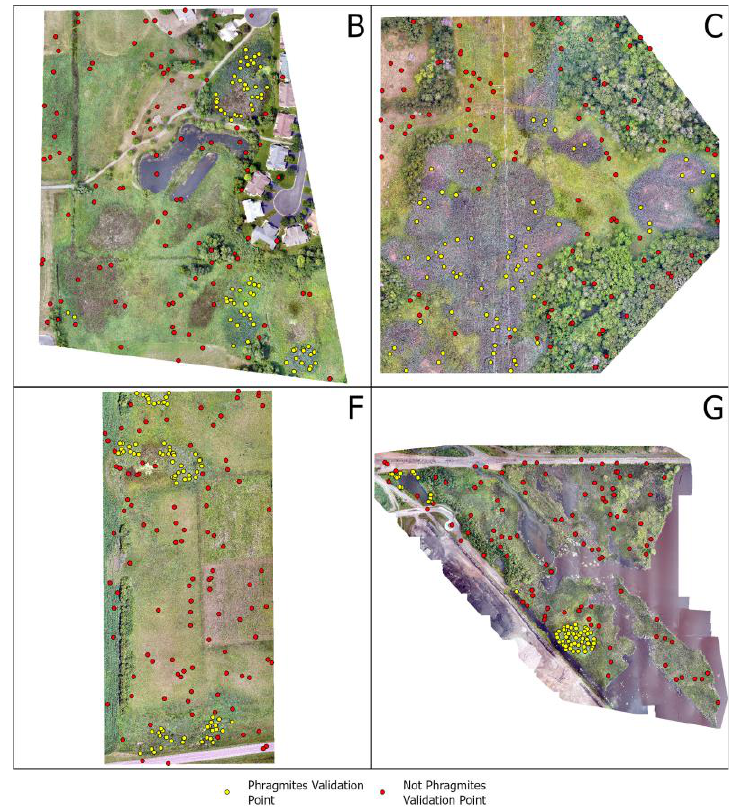
Figure 6. Location of validation points by cover class for Delano City Park ( B ), Chisago City ( C ), the Swan Lake WMA ( F ), and Grassy Point Park ( G ). Seventy-five Phragmites validation points were randomly selected, and one hundred Not Phragmites validation points were randomly selected.